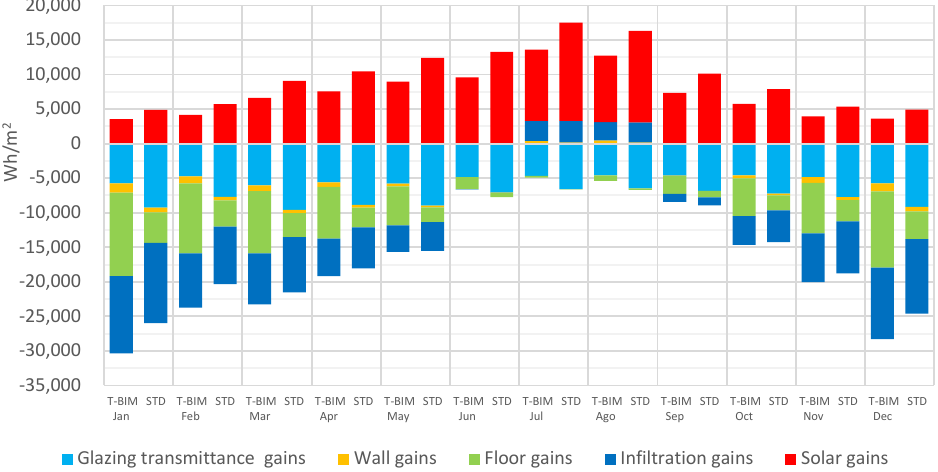
Figure 12. Means of monthly average monthly energy gains obtained by energy simulations of the two models, as-is STD and as-is T-BIM, on a TMY 2007–2021. There were differences between both models for solar gains through the glazing due to the different dimensions of the window panes. In the transmittances, even though the U win.pane was the same for both models, it must be taken into account that the as-is STD model presented the global value with the window frames, while the as-is T-BIM model was exclusively calculated with the U value of the window panes.